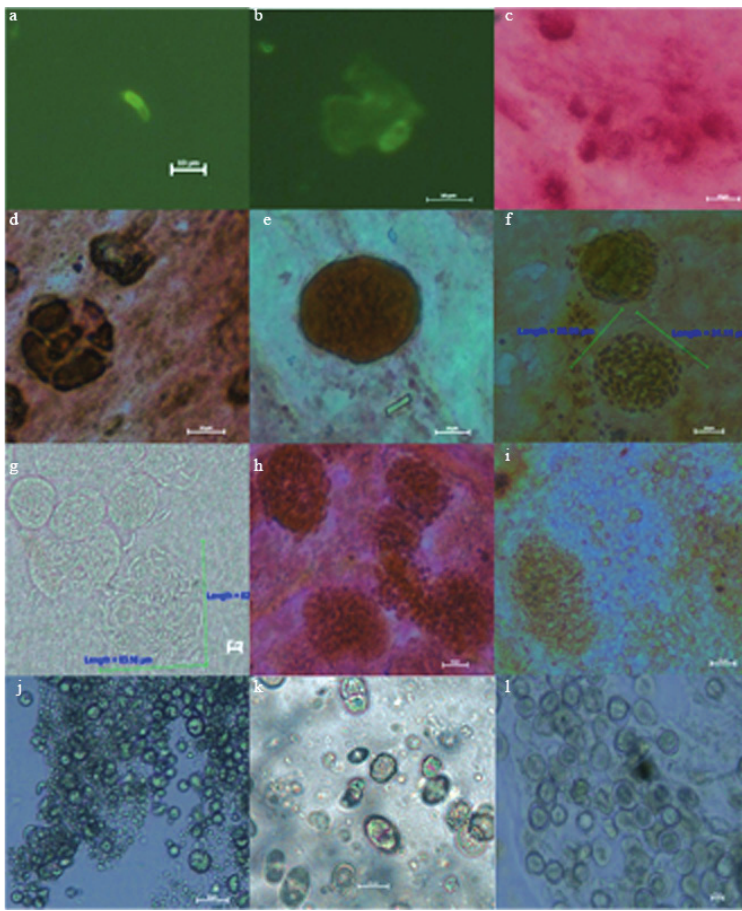
Fig. 2. – Sporozoites, trophozoites, schi- zonts, gamonts and oocysts in embryos at various times after inoculation